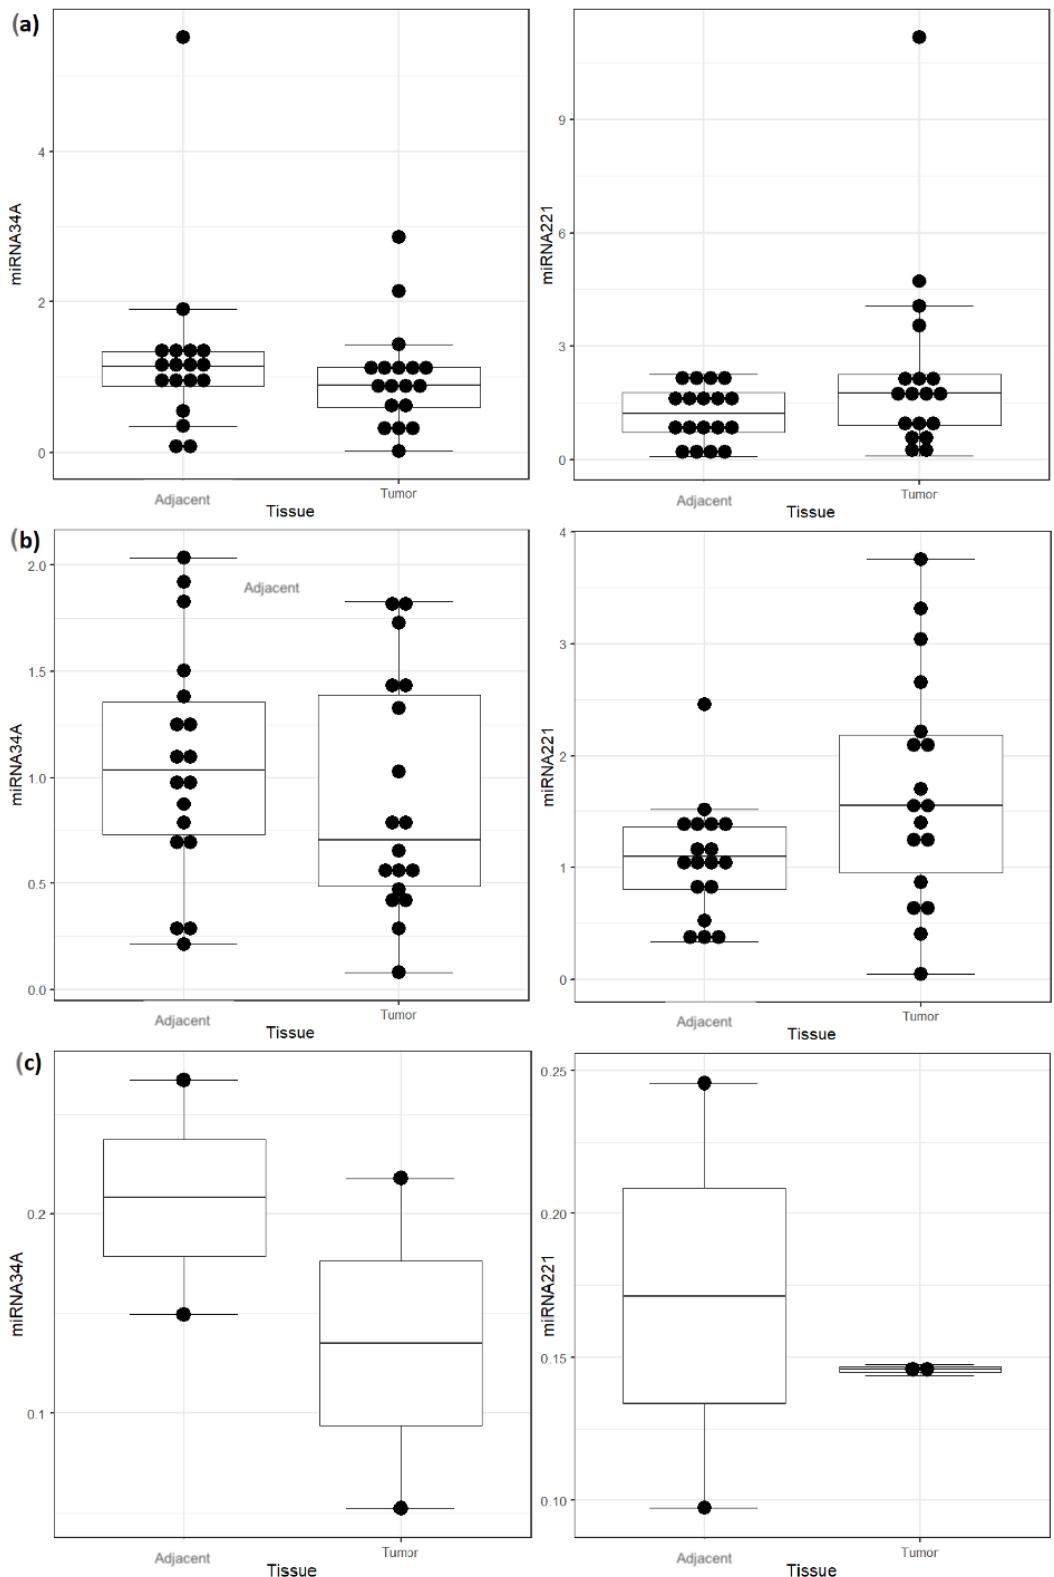
Figure 1. Comparison between tumoral and normal tissue regarding miRNA-34A and miRNA-221 ex- pressions. ( a ) basocellular carcinoma, ( b ) squamous cell carcinoma, ( c ) baso-squamous cell